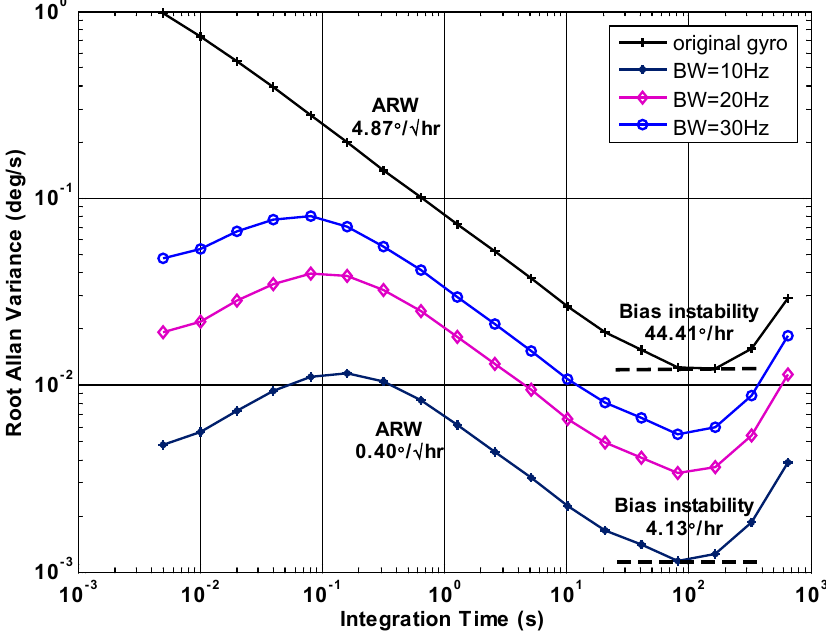
Figure 5. Allan variance compared result of gyroscope under different KF